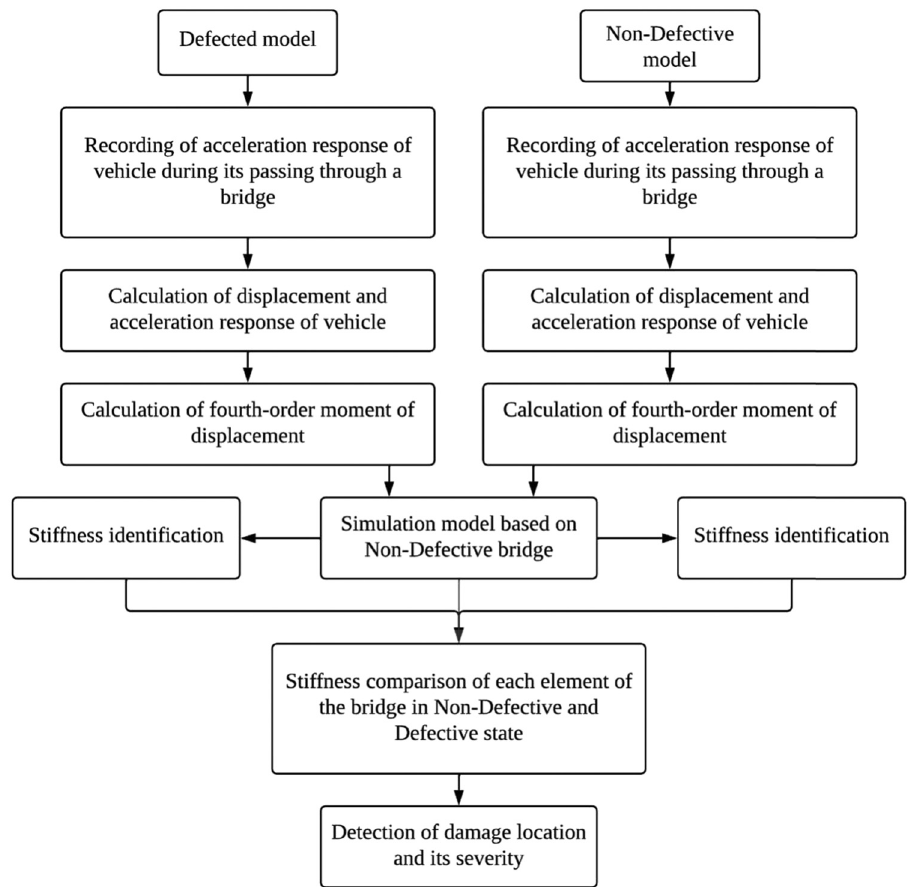
Figure 1: Bridge damage identi fi cation